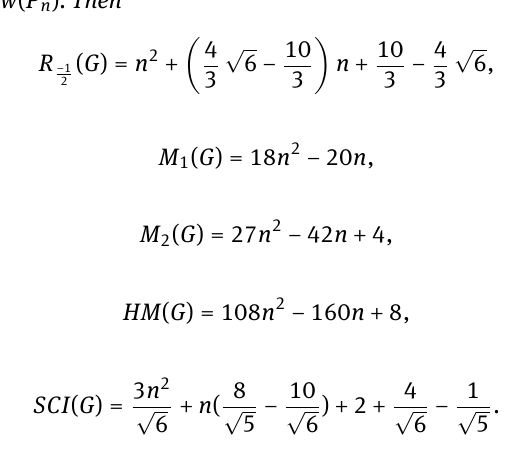
compute Randić connectivity, first and second Zagreb, hy- per Zagreb and sum connectivity indices of OTIS swapped network Bsw ( P ). n